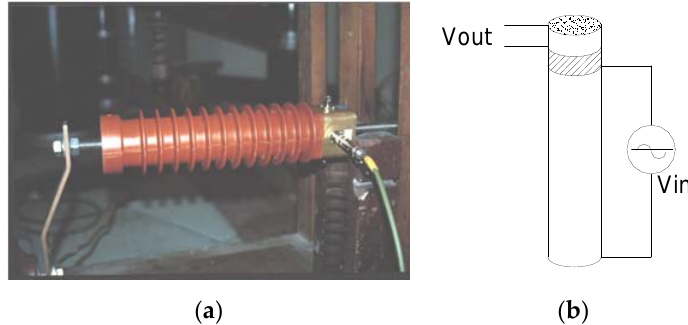
Figure 23. Non-resonant piezoelectric transformer for measuring high voltages in power distribution networks. ( a ) Piezoelectric measuring transformer inside of a high voltage testing chamber, ( b ) Sketch illustrating the principle of operation of the high voltage measuring transformer.